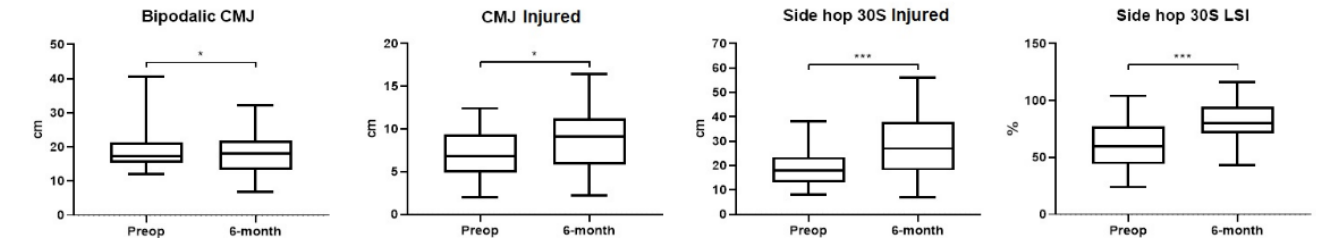
Figure 6. Box-plots showing differences in jumping performances from pre-operative to 6-month follow-up after surgery. The black line inside the box represents median value. The lowest bar represents the minimum value, the bottom and top of the boxes represent the interquartile range (25th and 75th percentiles), and the top bar represents the maximum value. * p < 0.05; *** p < 0.001.